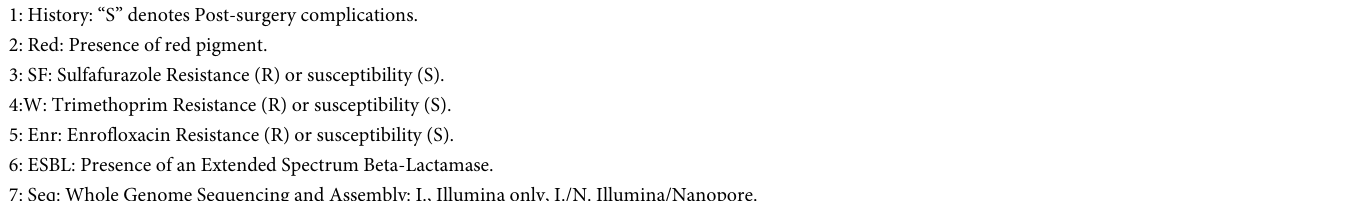
Sensititre broth microdilution results confirmed that these MDR isolates had higher Minimum Inhibitory Concentration (MIC) values with 3 rd generation cephalosporins and flu- oroquinolones, as well as with gentamicin and trimethoprim-sulfamide combination (Table 2). No resistances were noted for carbapenems and piperacillin/tazobactam in any of the iso- lates. As expected, resistances considered to be intrinsic to the genus Serratia , namely against ampicillin, amoxicillin-clavulanate, first generation cephalosporins and tetracycline, were observed in all isolates.